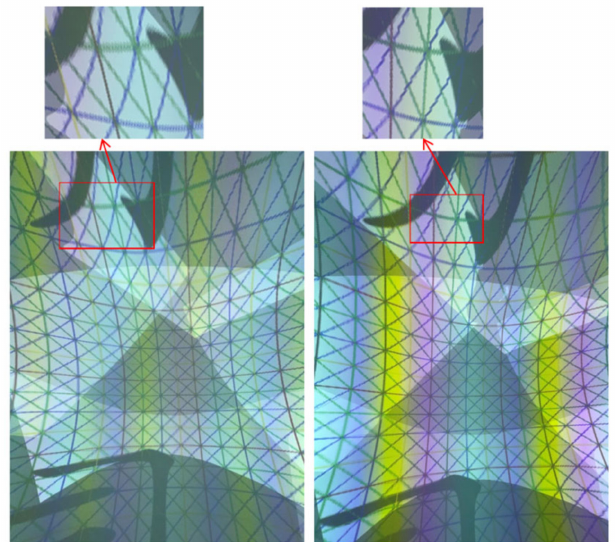
Figure 14. Comparison of projection stitching effect.